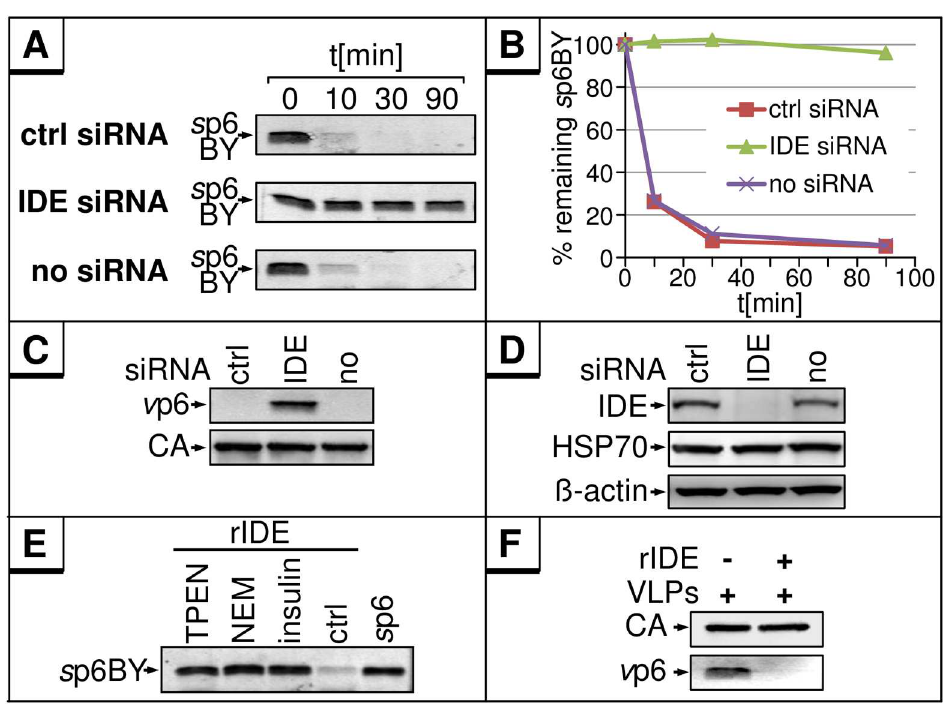
Fig 6. IDE is sufficient and required for the in vitro degradation of s p6 and v p6. (A) 10 ng s p6BY were incubatedwith 5 μ g S10 extract from HeLa cells, either untransfected or transfected with control or IDE- specific siRNA, for 0, 10, 30 or 90 min at 37˚C. (B) s p6BY was detected by fluorescence emissionand quantified. (C) VLP lysates from HEK293T cells were incubatedwith S10 from siRNA treated cells described in A. Viral proteins were detected as describedin Fig 1. (D) Western blot analysesof the S10 extract used in A and C. The membranewas stainedwith antibodiesspecific for IDE, HSP70, and β -actin. (E) 10 ng rIDE were incubatedwith 10 ng s p6BY and either TPEN (1 mM), NEM (1 mM), insulin(100 μ g/ml) or buffer for 30 min at 37˚C. (F) VLP lysates were incubatedwith 10 ng rIDE for 30 min.